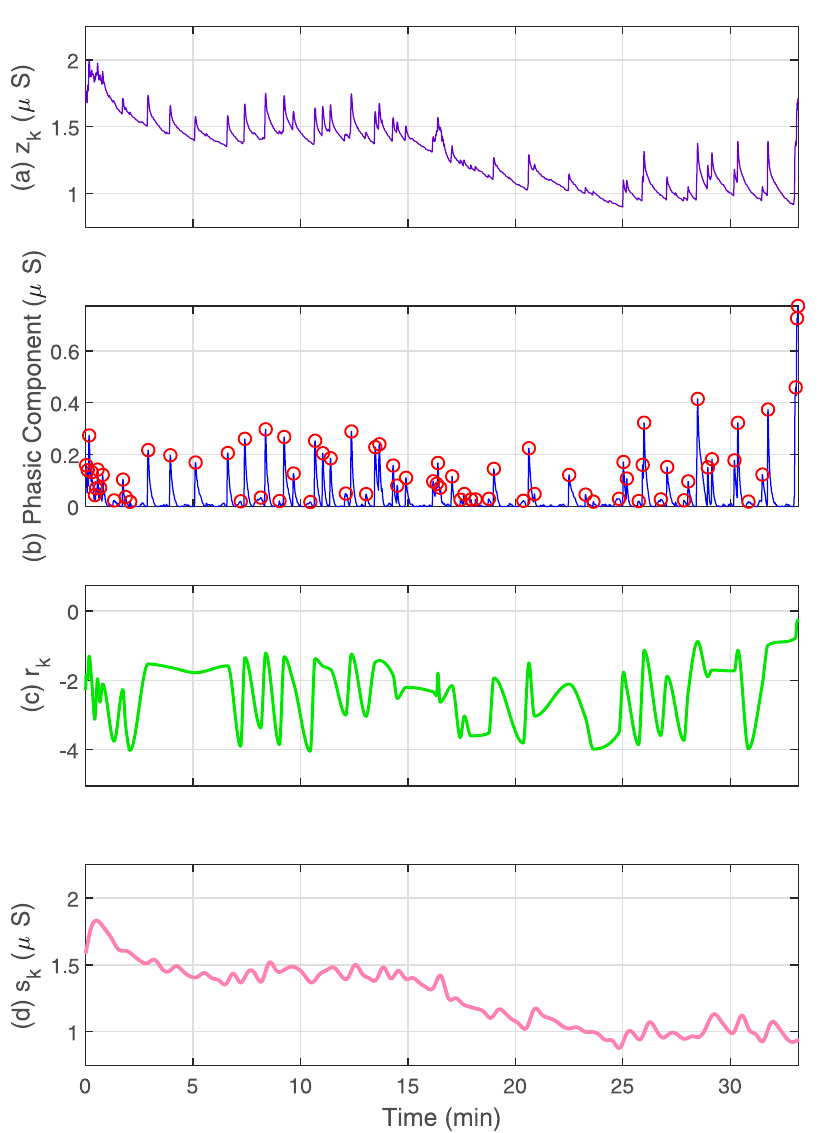
Fig 4. Constituent components of a skin conductance signal. The sub-panels from top to bottom respectively depict, (a) the skin conductance signal z ; (b) the phasic component with the detected SCR peaks; (c) the phasic-derived k component r k ; (d) the tonic component s k . m k = 1 or m k = 0 is assigned based on whether or not an SCR occurred at the k th time-point. We make use of the observations m , r and s at each time point to estimate x k k k k